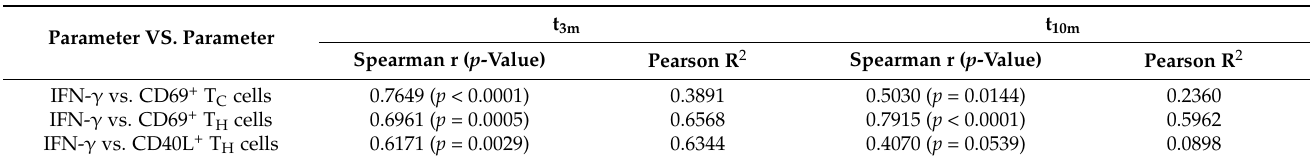
Table 2. Correlation of SARS-CoV-2-specific cellular parameters measured after BNT162b2 vaccina- tion.